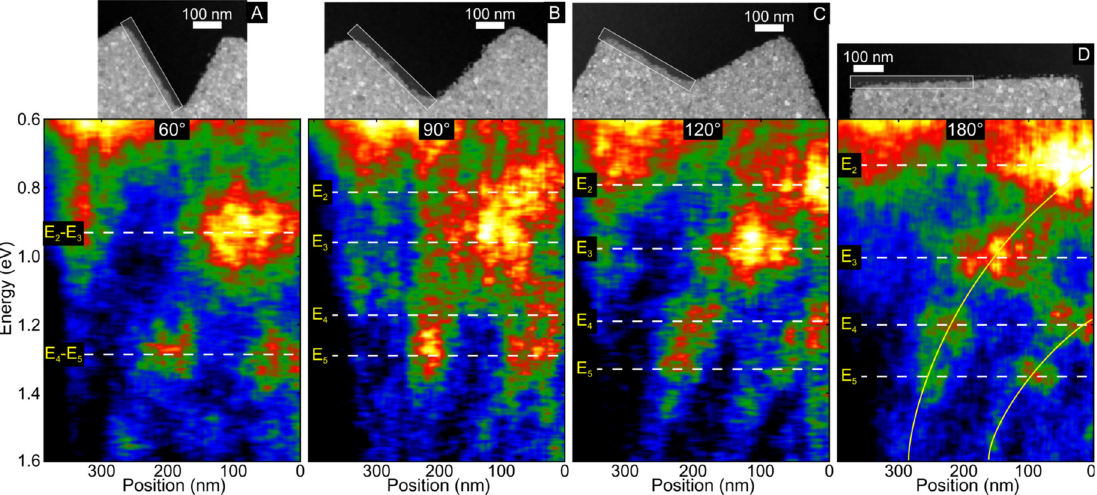
Figure 6: EELS intensity profile of isolated edges with 60 ◦ (A), 90 ◦ (B), and 120 ◦ (C) bending angles, as well as of a straight edge (D). It shows how the nodal distribution of the edge modes changes due to the presence of a bend. The EELS profiles are acquired in the region indicated by the boxes in the ADF